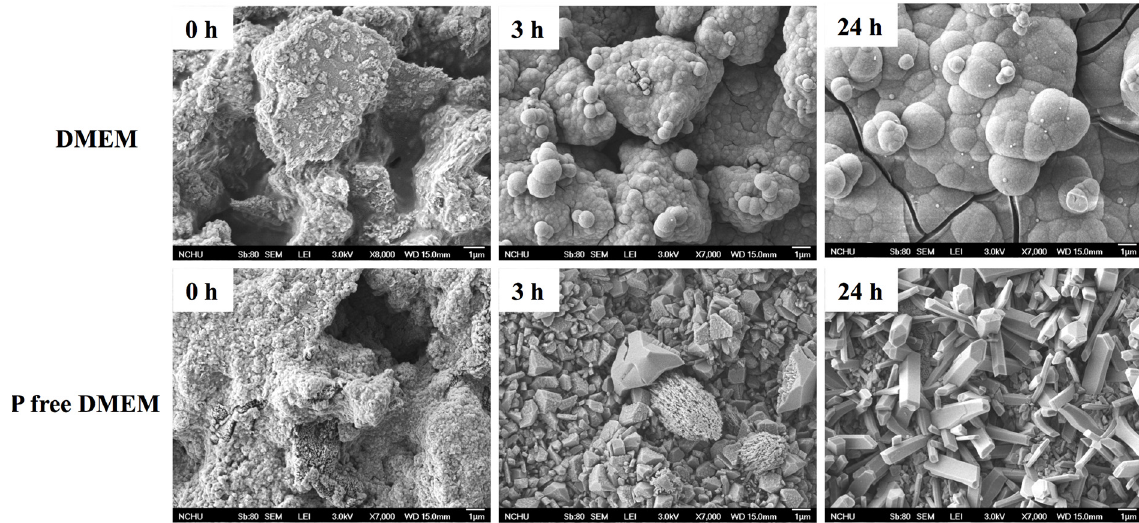
Figure 2. SEM micrographs of the CS surfaces before and after immersion in DMEM and P-free DMEM for different time